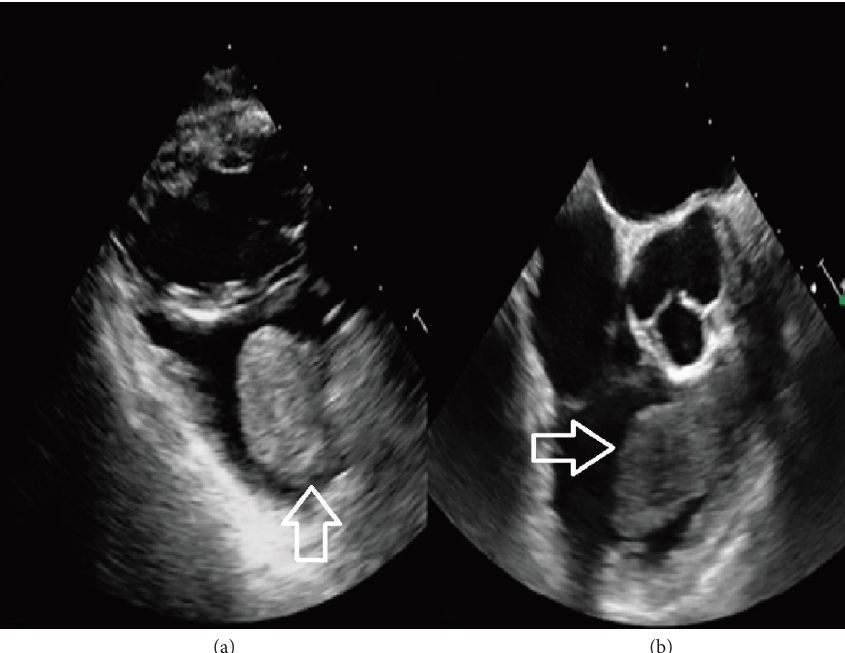
Figure 3: Transesophageal echocardiographic views of the RV mass. (a) Shows trans-gastric views which demonstrates the attachment of the mass to the undersurface of tricuspid annulus adjacent to the anterior tricuspid leafet (white arrow). (b) Shows the short axis view where the RV mass (white arrow) is visualized traversing the pulmonary valve.